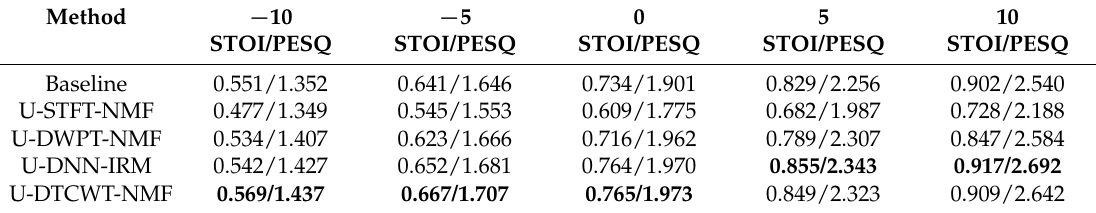
Table 5. Comparison between the U-DTCWT-NMF and the other three unseen noise case methods.